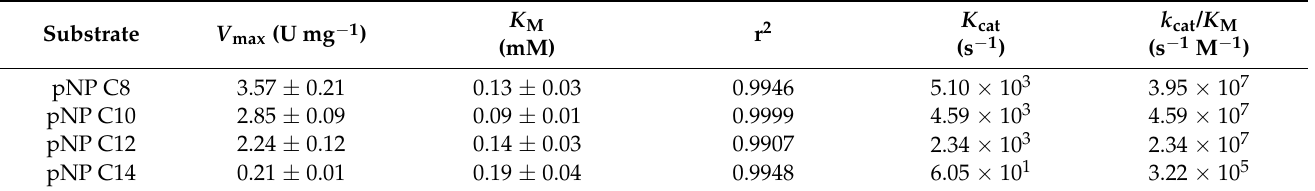
Table 2. Michaelis–Menten (MM) kinetic parameters retrieved for KLEST-3S activity against different chain length p-nitrophenyl esters.